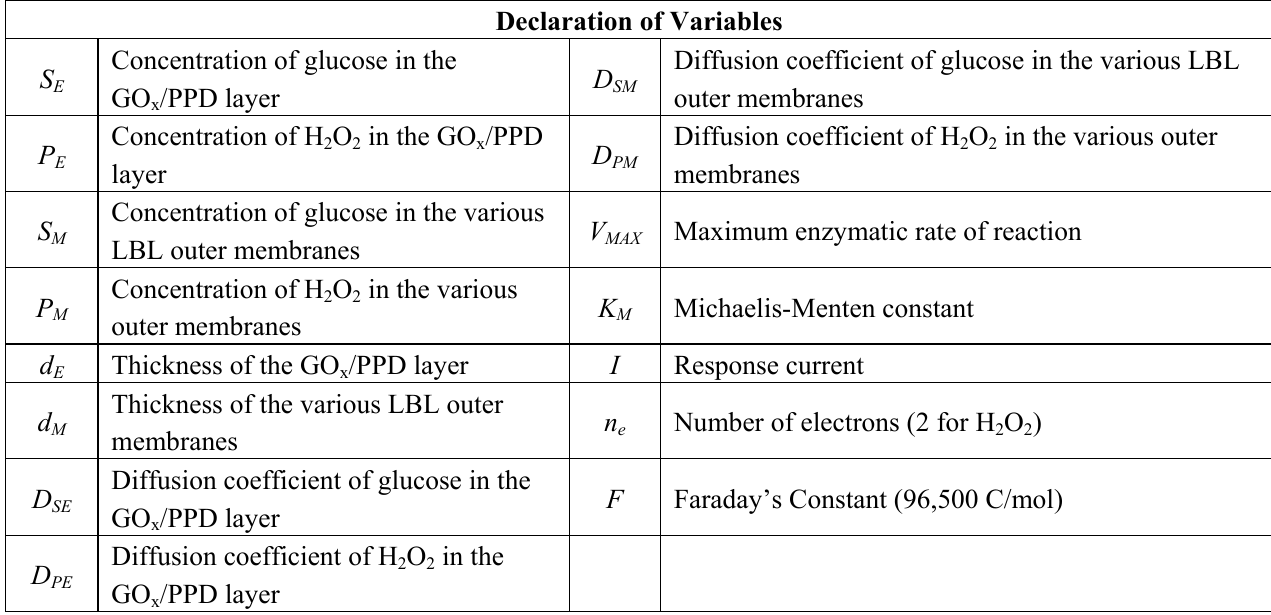
Table 1. Compilation of variables used in the multi-layer model. Declaration of